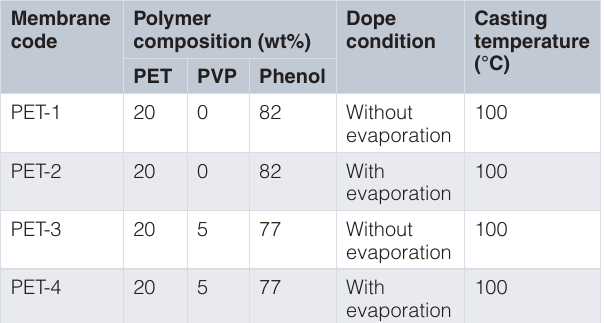
Table 1. The composition of dope